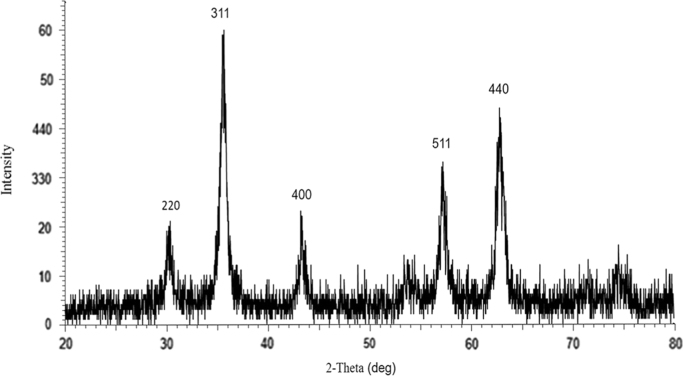
XRD pattern of the bare Fe3O4.